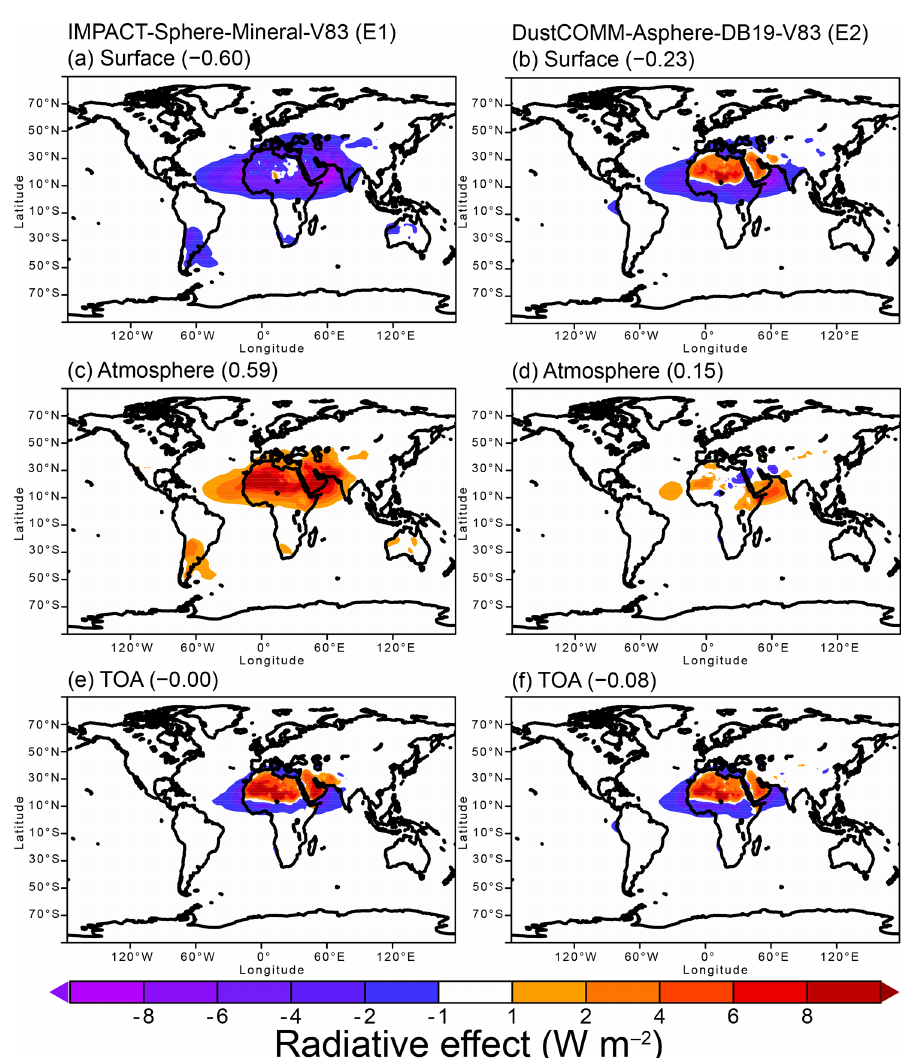
Figure 8. Dust net radiative effect (Wm − 2 ) and radiative heating of the atmosphere (i.e., the subtraction of radiative effects from TOA to the surface in units of Wm − 2 ). The model results are shown for the simulations for (a) IMPACT-Sphere-Mineral-V83 (E1) at the surface, (b) DustCOMM-Asphere-DB19-V83 (E2) at the surface, (c) E1 in atmospheric column, (d) E2 in atmospheric column, (e) E1 at TOA, and (f) E2 simulations at TOA. The numbers in parentheses represent the global